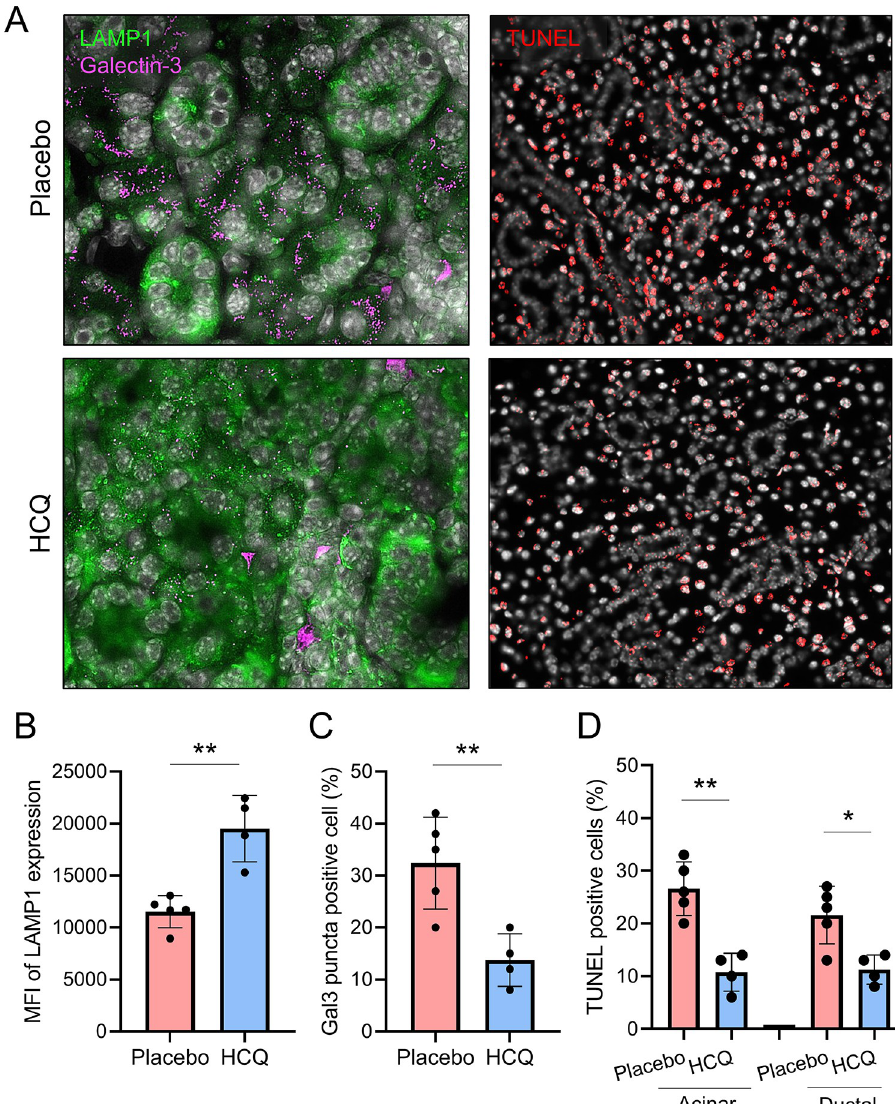
Fig 3. Hydroxychloroquine treatment decreases LAMP3-induced cell death in vivo . Submandibular glands of C57BL/6 mice were instilled with AAV2-LAMP3. After 4 months, mice were given weekly intraperitoneal injections of 60 mg/kg HCQ ( n = 4) or placebo ( n = 5) for 3 months. ( A ) Representative submandibular gland tissue sections showing staining for LAMP1 (green) and galectin-3 (magenta) (40 × magnification) or terminal deoxynucleotidyl transferase dUTP nick-end labeling (TUNEL, red) (20 × magnification). ( B ) Bar chart shows mean fluorescence intensity of LAMP1 expression. ( C ) Bar chart shows percentage of galectin-3 (Gal3) puncta-positive cells. ( D ) Bar chart shows percentage of TUNEL-positive epithelial cells. Values shown are mean ± SD. � P < 0.05, �� P < 0.01, N.S. = not significant (Student’s t